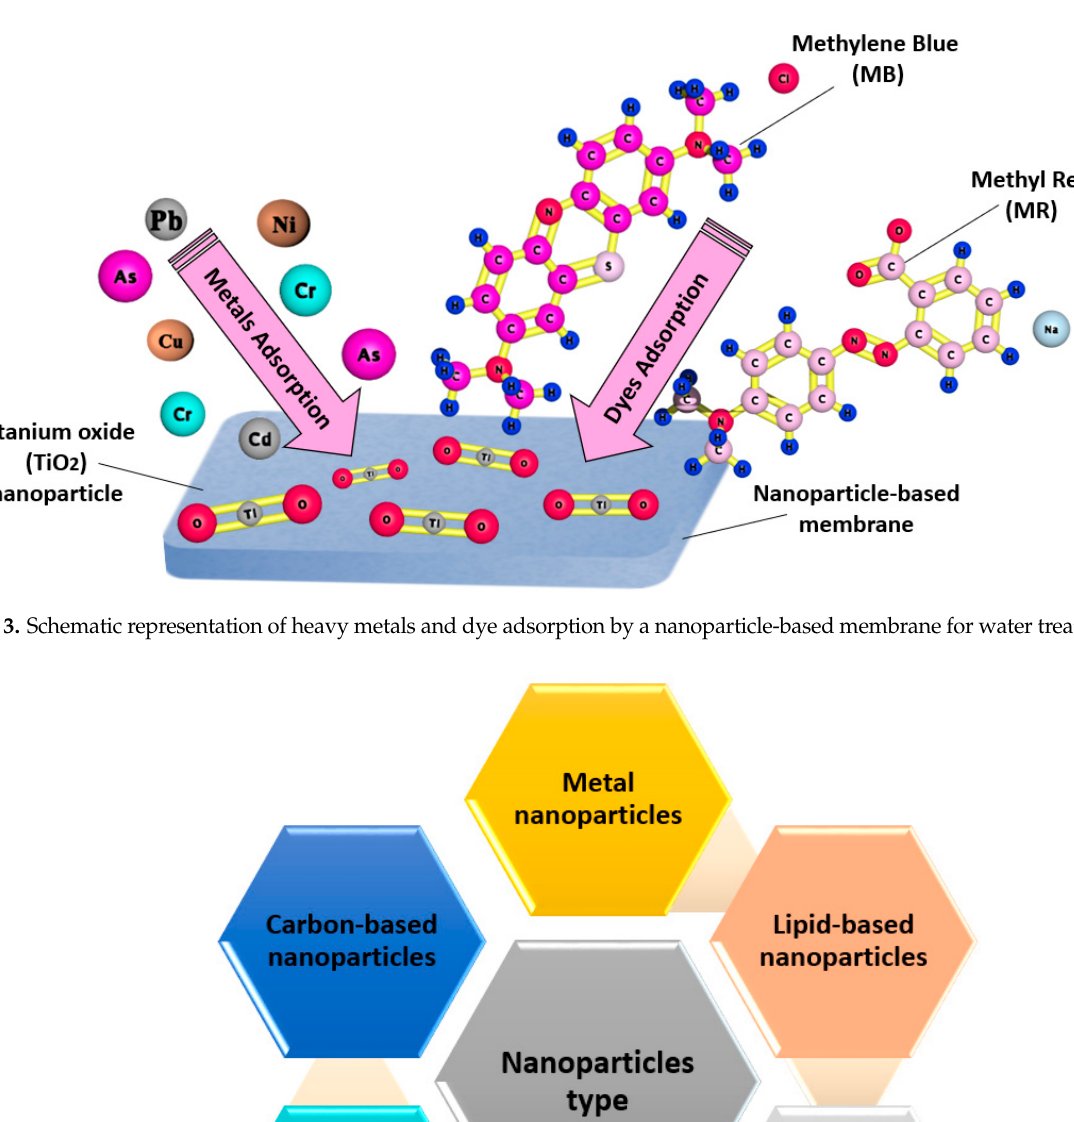
Membranes 2021 , 11 , x FOR PEER REVIEW 10 of 37